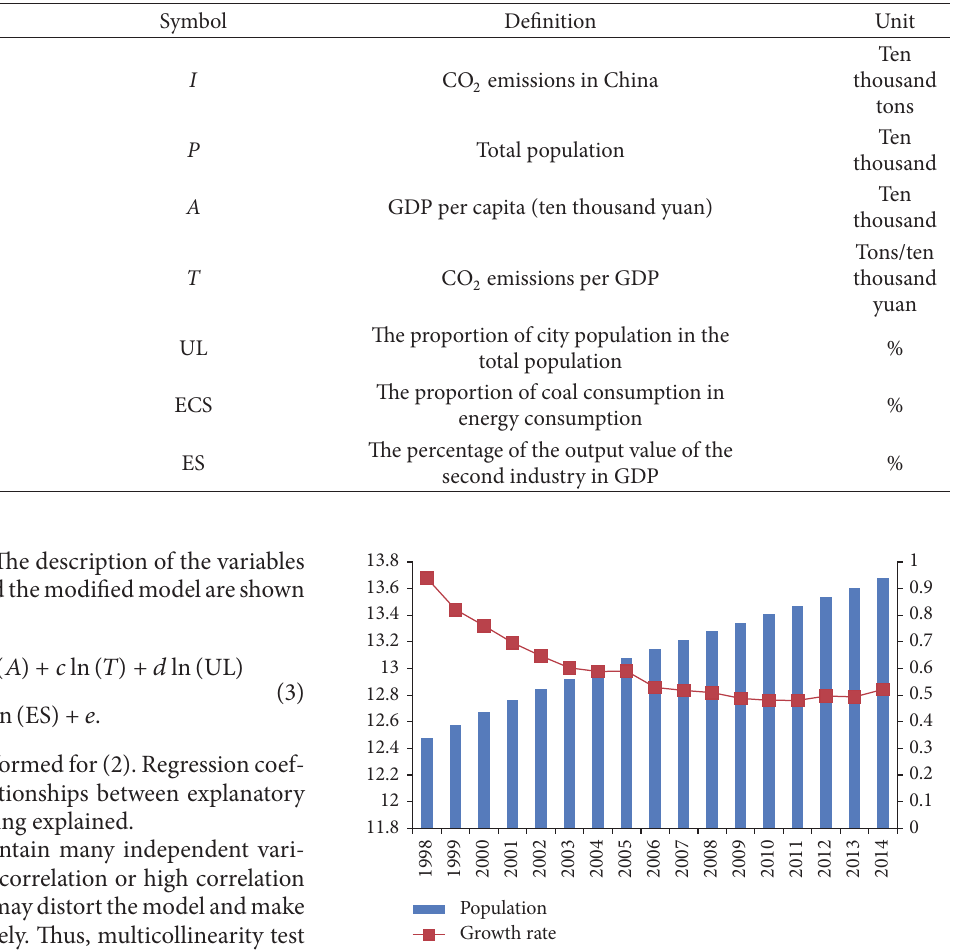
Table 1: Description of the variables used in the paper.